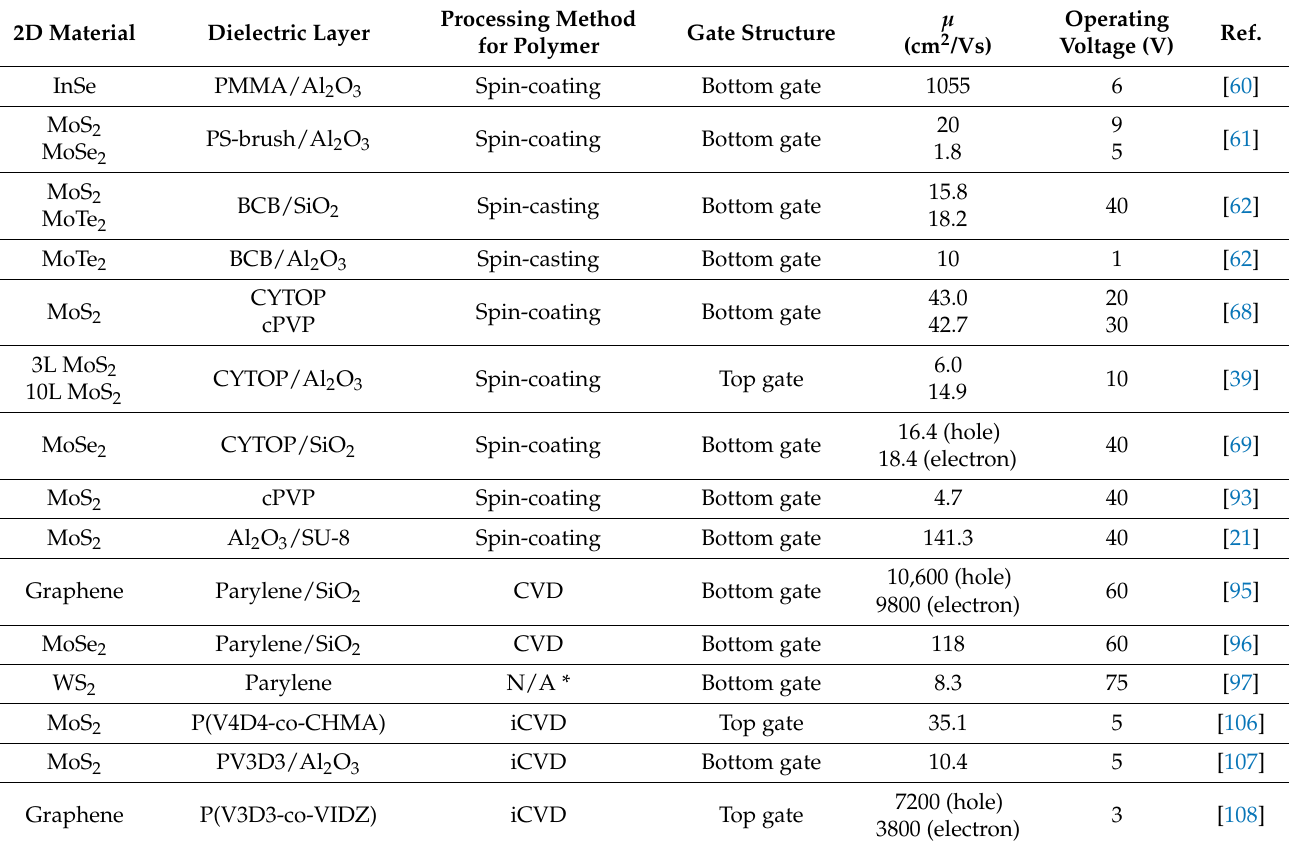
Table 1. Summary of the materials, processing methods, device structures, and electrical characteris- tics for 2D semiconductor FETs based on polymer gate